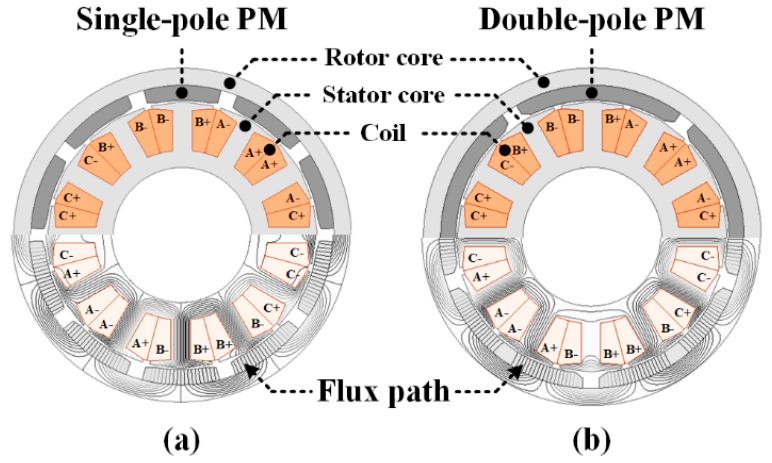
Figure 1. Analysis models and their flux path: ( a ) Single-pole magnetization BLDC (brushless DC) motor and ( b ) initial double-pole magnetization BLDC motor.